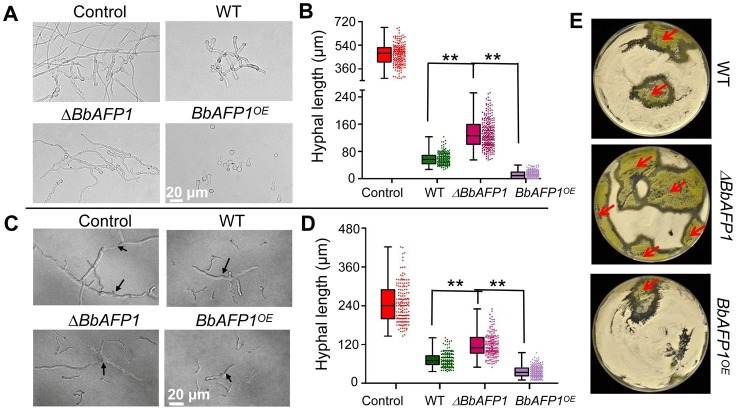
Consequence of BbAFP1 targeted gene deletion and overexpression on Trichoderma sp. antifungal activity.(A, B) Representative images and quantification of fungal growth inhibition using protein fractions released from conidia (ultrasonic treatment) of B. bassiana wild type, ΔBbAF1P and BbAFP1OE as evaluated against Trichoderma sp. growth in PDB, 28 h post-treatment. (C, D) B. bassiana-Trichoderma sp. co-culture experiments. Representative images and quantification of B. bassiana wild type, ΔBbAF1 and BbAFP1OE on conidial germination of Trichoderma sp. on CZA using a B. bassiana test strain:Trichoderma sp. initial conidial ratio = 10:1. Growth inhibition was evaluated after 17 h of co-cultivation. Black arrows indicate Trichoderma sp. (E) B. bassiana test strain-Trichoderma sp co-cultivation using an initial conidial ratio = 10:1 and plated on CZA 4 d post-coinoculation. Red arrows indicate Trichoderma sp. colonies. All experiments were performed in triplicate with at least three independent biological samples. Error bars = SD, ** indicates P < 0.01, t-test.